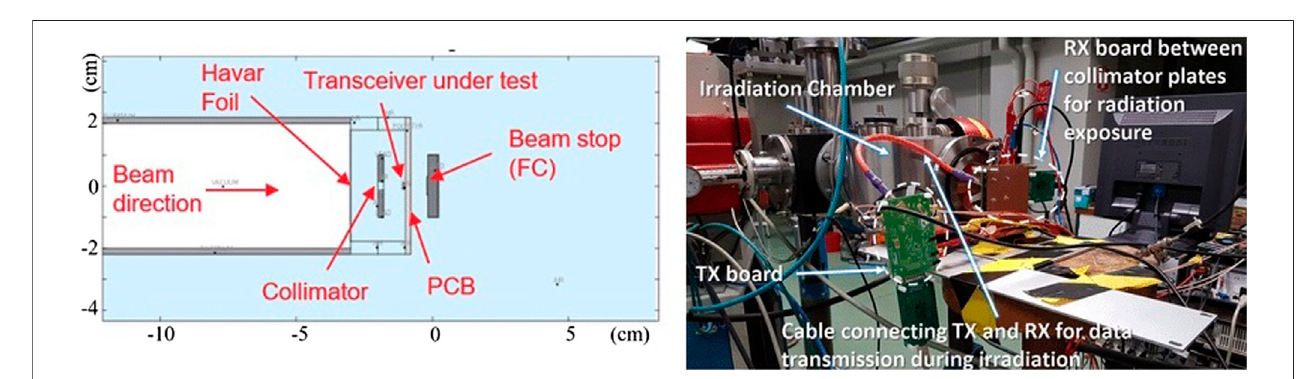
FIGURE 15 | irradiation tests at Turku